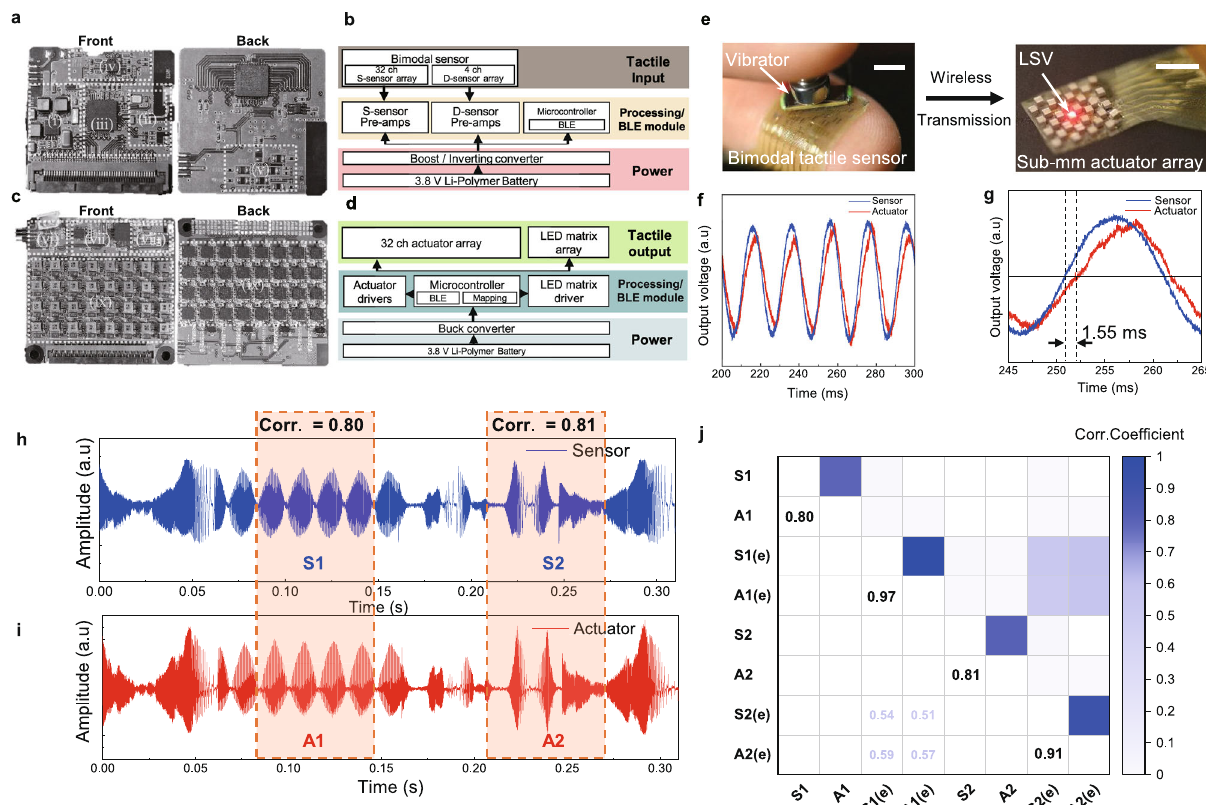
Fig. 4 Wireless tactile acquisition and rendering system for telehaptic communication. a Image of wireless tactile acquisition module. It illustrates the integrated circuit components of the UFB sensor array: (i) boost/inverting converter, (ii) BLE module, (iii) Microcontroller, (iv) 4 ch D-sensor array, and (v) 32 ch S-sensor array. b System block diagram of tactile acquisition from the UFB sensor array. c Image of wireless tactile rendering circuit board: (vi) Buck converter, (vii) Microcontroller, (viii) BLE, and (ix) 32 ch actuator drivers. d System block diagram of tactile rendering from a tactile actuator array. e Image of the UFB tactile sensor (left) applying tactile stimuli patterns with a vibrator. The sub-mm actuator array (right) measures the vibration amplitude and the acceleration using a LSV, scale bar is 5 mm. f Wireless transmission of tactile stimuli. The sensor output (red) and actuator velocity (blue) was measured while 50 Hz was applied to the sensor using a vibrator. g The delay time between sensor output (red) and actuator output (blue). Sensor signal was wirelessly transmitted, and the vibration was measured by LSV. h the tactile signals (blue) recorded by UFB tactile sensor, while tactile stimuli were applied by the vibrator. i Vibrational displacement (red) of the actuator rendered by transmitted sensor signals. j Correlation matrix correlogram of signal patterns describing the correlation coef fi cient between the signals acquired by the sensor (S1, S2) and the rendered actuator signals (A1, A2). The S1(e), S2(e) and A1(e), A2(e) were envelope of sensor and actuator signals,